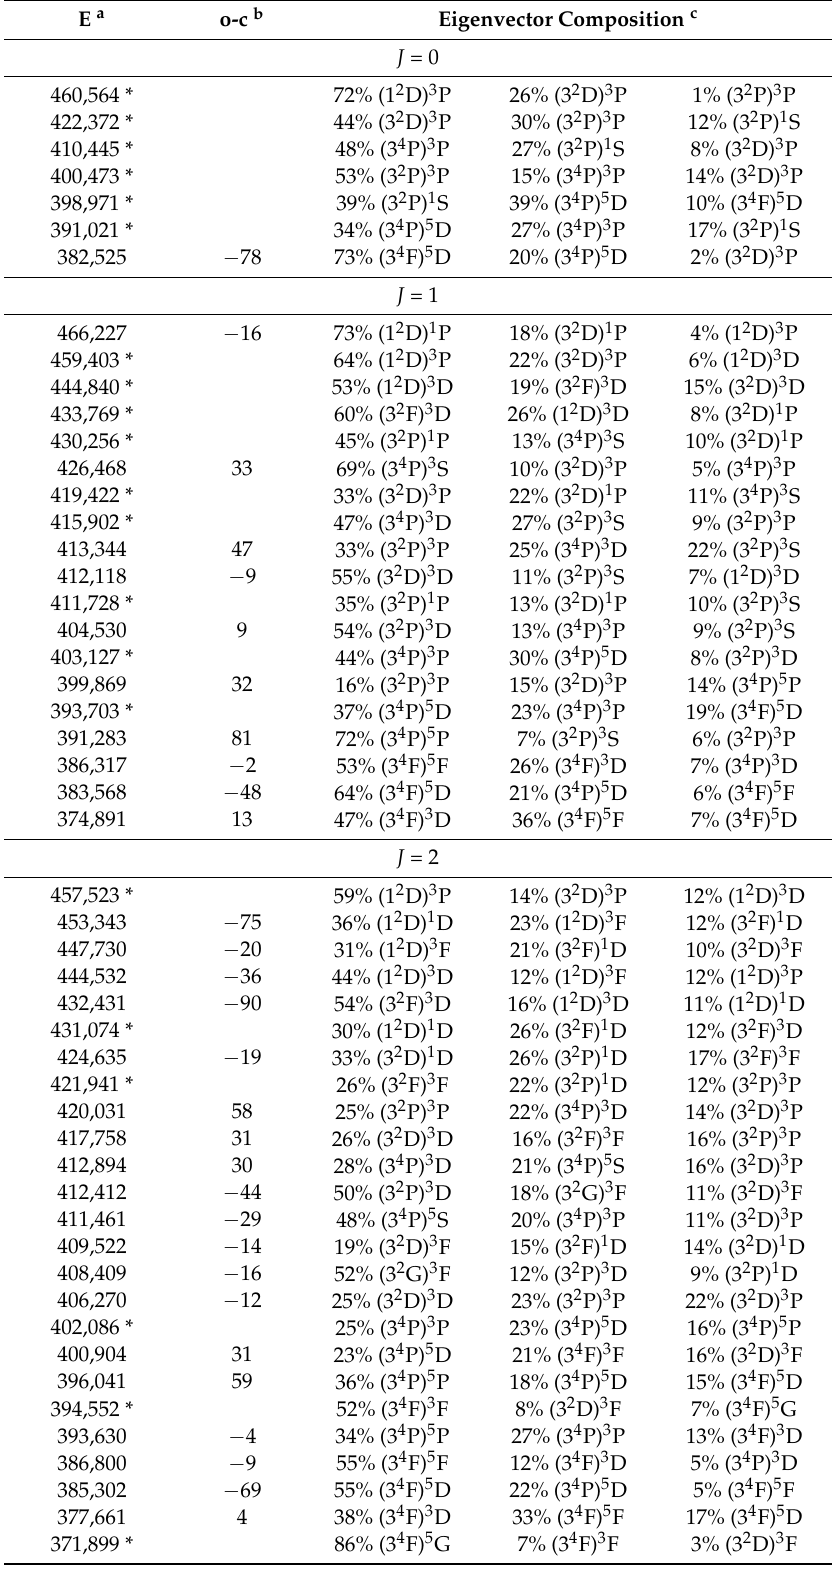
Table A8. Energies (in cm − 1 ) of the 4d 3 5p configuration of Ag